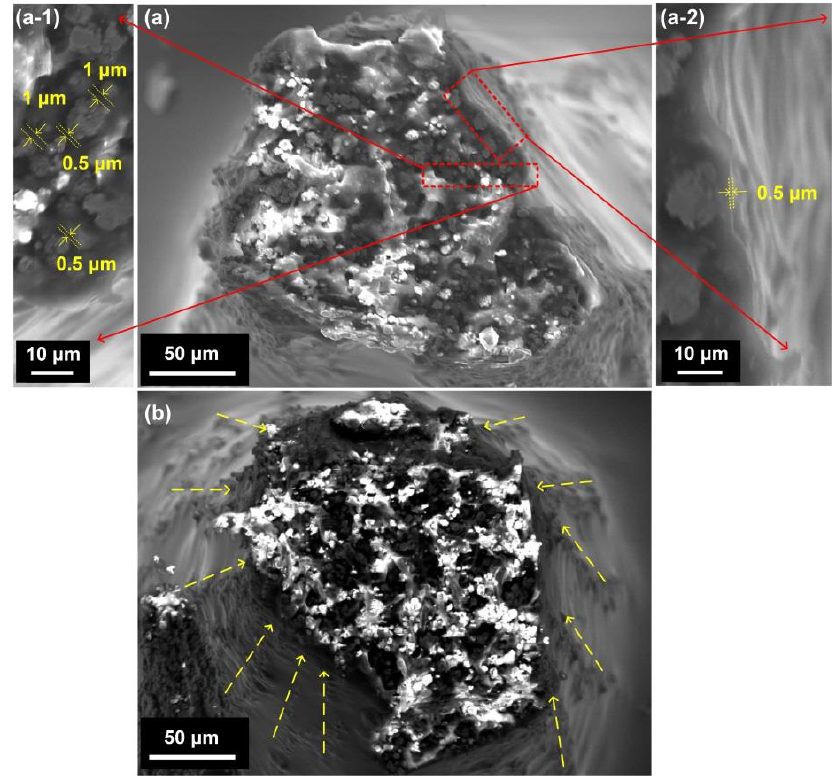
Figure 7. Cross section of the vertical protrusive Shape Memory Polymer / Nickel (SMP / Ni) chain (( a ) 2 vol% Ni; ( b ) 5 vol%